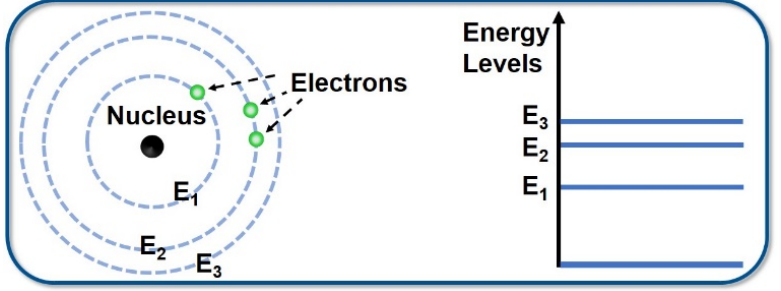
Figure 3. Transition level diagram of electrons.